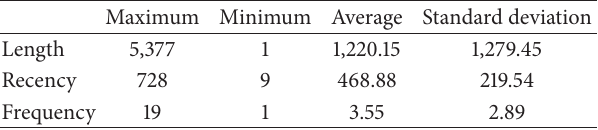
Table 2: The descriptions of length, recency, and